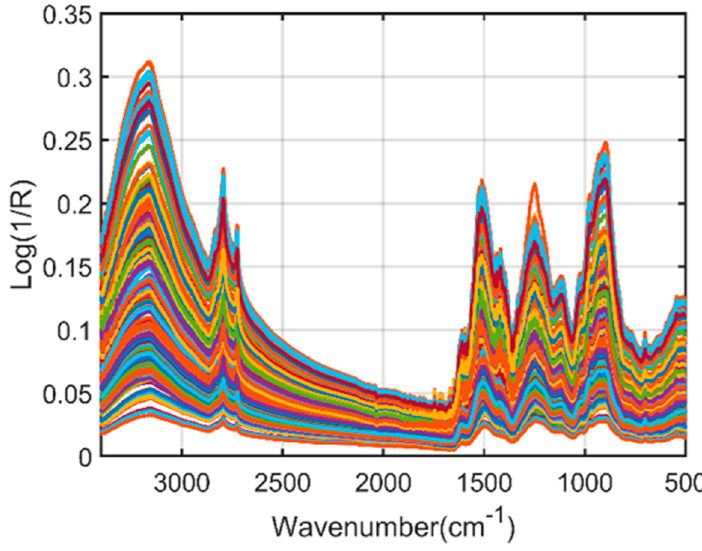
Figure 1. Fourier-transform infrared (FT − IR) raw spectra of A. thaliana powder samples .